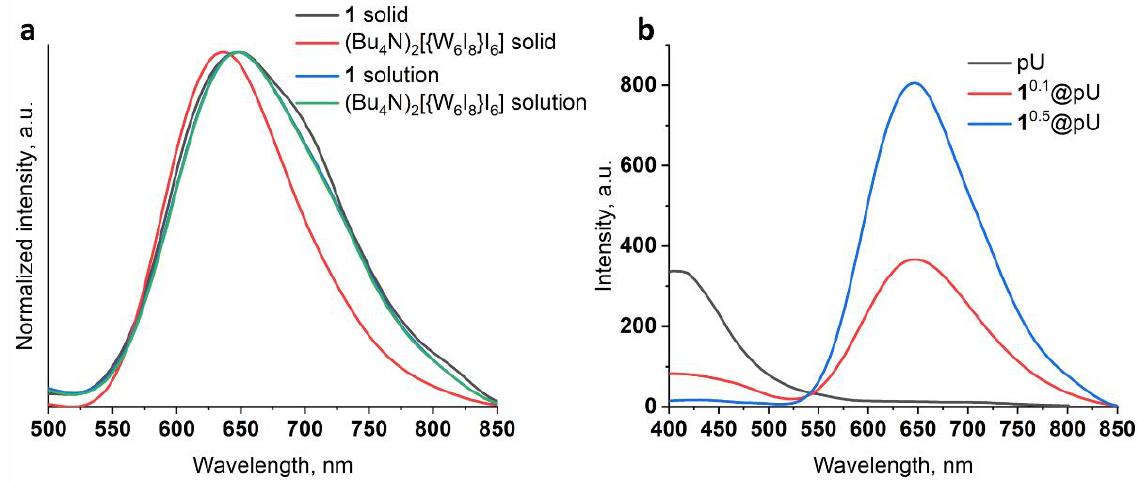
Figure 3. ( a ) Normalized luminescence spectra of (Bu 4 N) 2 [{W 6 I 8 }I 6 ] and 1 in acetonitrile solution and in a solid state; ( b ) luminescence spectra of 1, 1 0.1 @pU, and 1 0.5 @pU in a solid state.